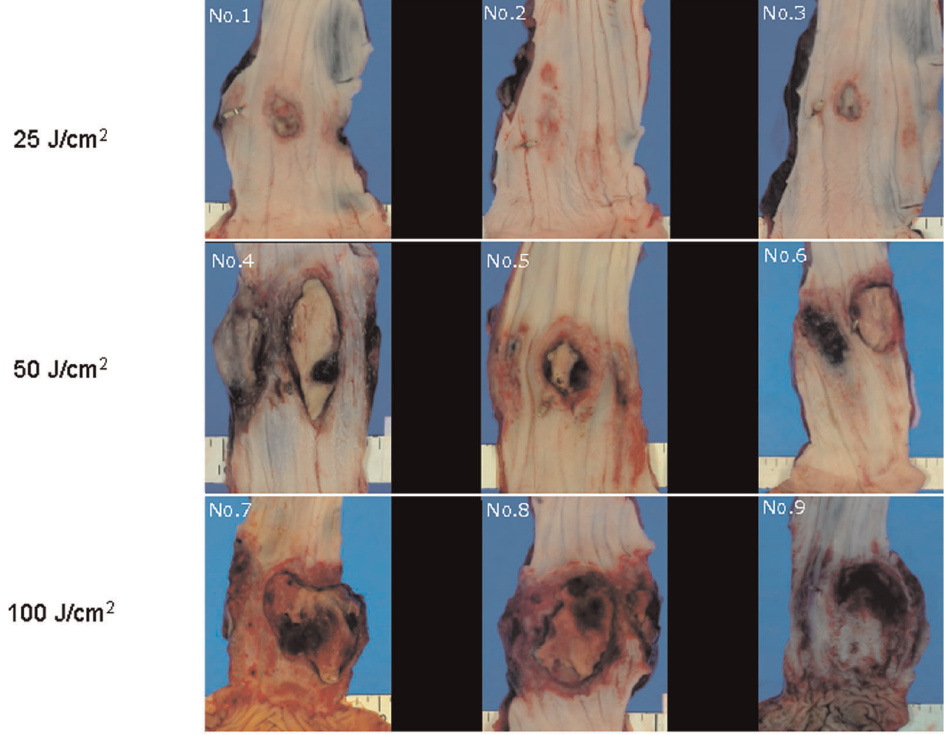
Figure 4. Macroscopic findings in the esophagus. Mucosal redness and ulceration were observed in all dogs in the 25 J/cm 2 group (A–C). The areas of redness, erosion, and ulceration were more extensive in the 50 J/cm 2 and 100 J/cm 2 groups (D–I).